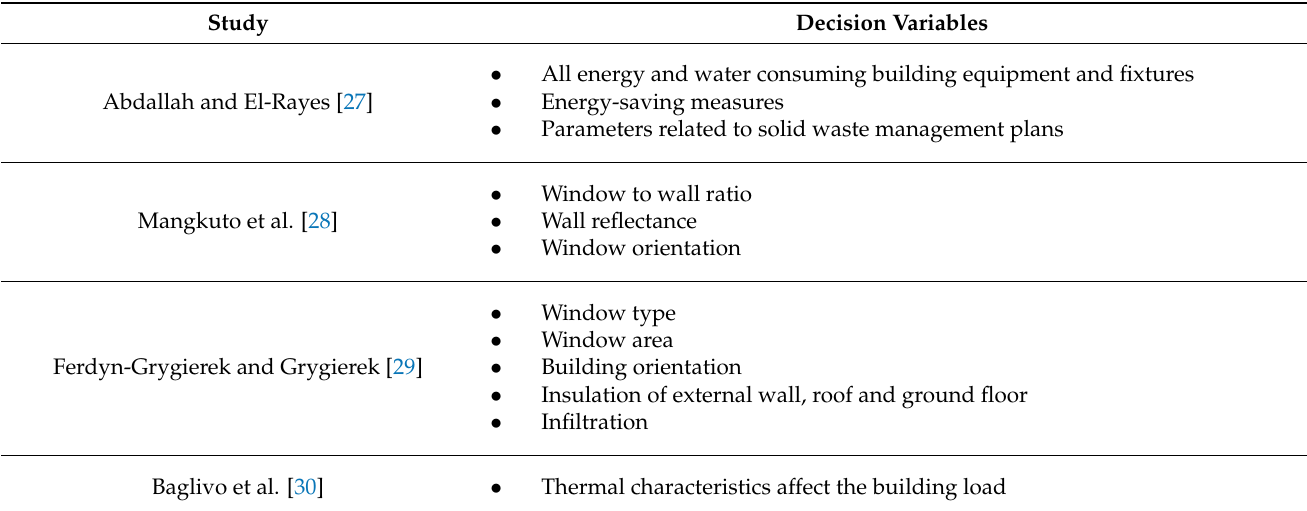
Table 4. Decision variables which have been considered in the core